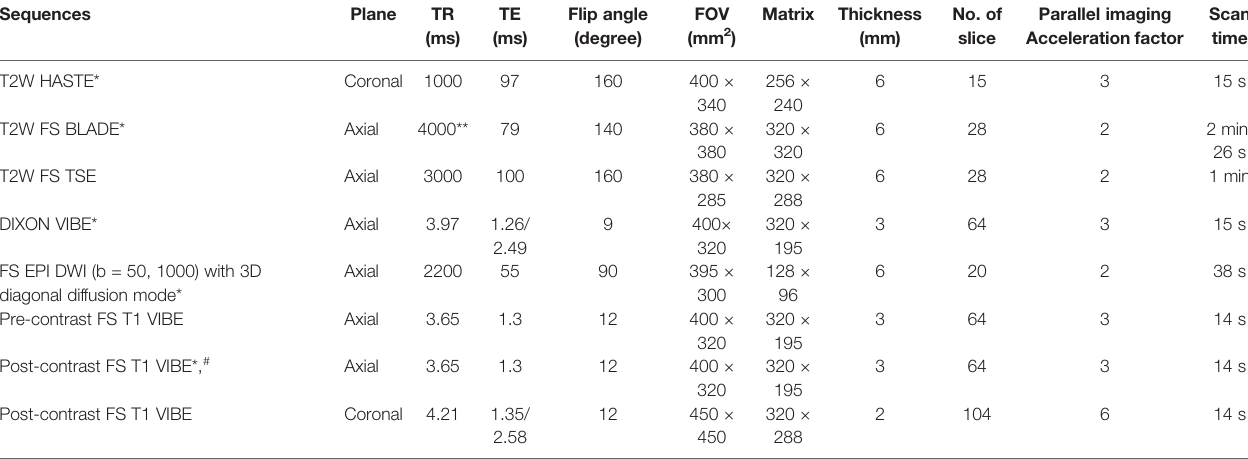
TABLE 2 | MRI parameters of the fast liver MRI scan and conventional liver MRI scan.